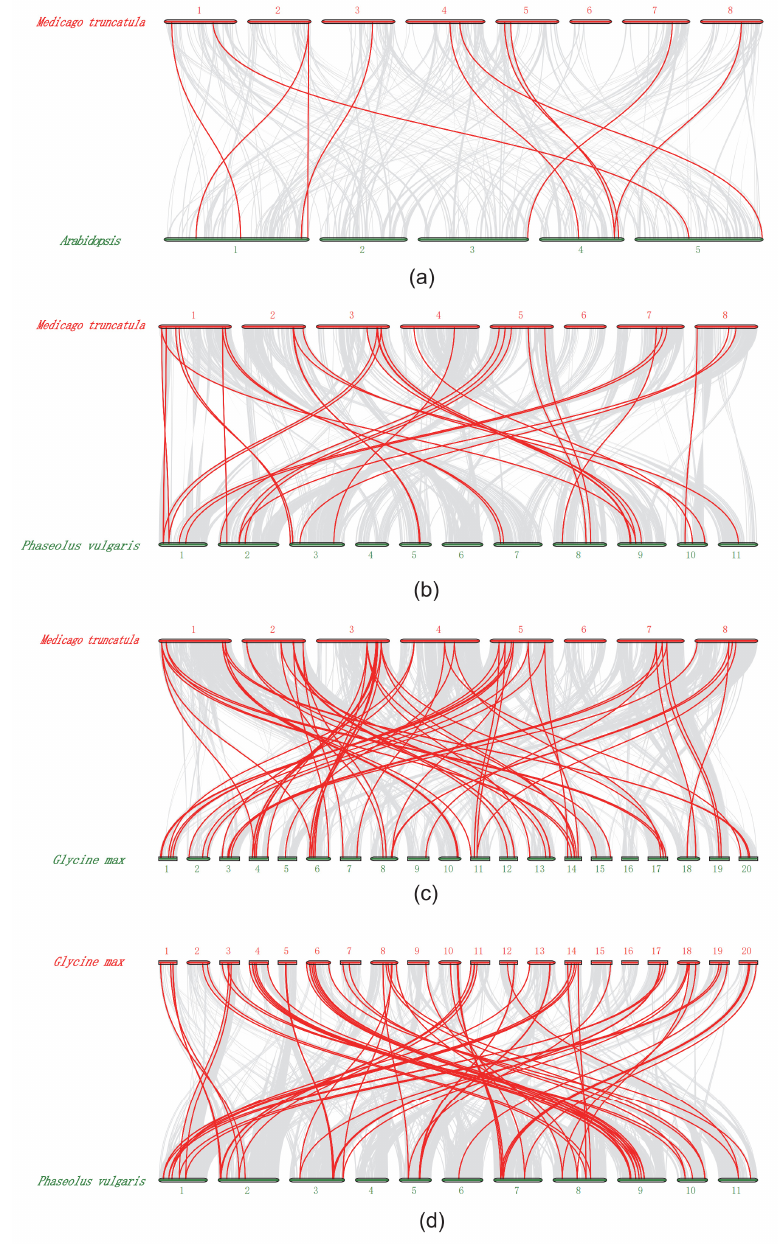
Figure 3. Synteny of cyclin genes in different genome of M. truncatula , Arabidopsis , soybean and common bean. ( a ) Synteny of Atcyclin and Mtcyclin gene pairs. ( b ) Synteny of Mtcyclin and Pvcyclin gene pairs. ( c ) Synteny of Gmcyclin and Mtcyclin gene pairs. ( d ) Synteny of Gmcyclin and Pvcyclin gene